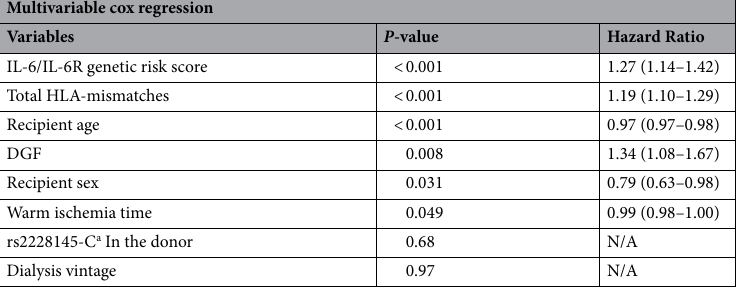
Table 5. Competitive analysis of the associations of clinical factors with rejection. Multivariable cox regression was performed with a stepwise forward selection. Only variables that with a P -value below 0.10 in the univariate analysis were included. Data are presented as hazard ratio with 95% confidence interval (CI) and P -value. The IL-6/IL-6R genetic risk score, total number of HLA-mismatches, recipient age, occurrence of delayed graft function (DGF), recipient sex and warm ischemia time were included in the final model. a Previously rs8192284.